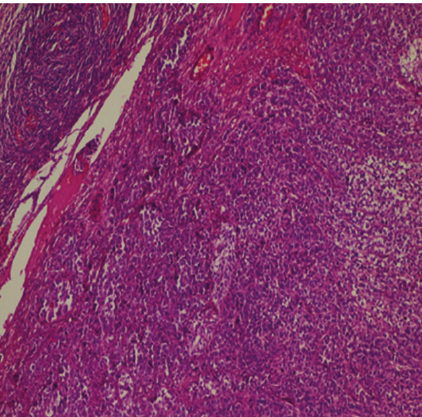
Figure 1: Photomicrograph showing stroma of ovaries and the rest of the staining lesion showing carcinoma (hematoxylin and eosin, × 100).